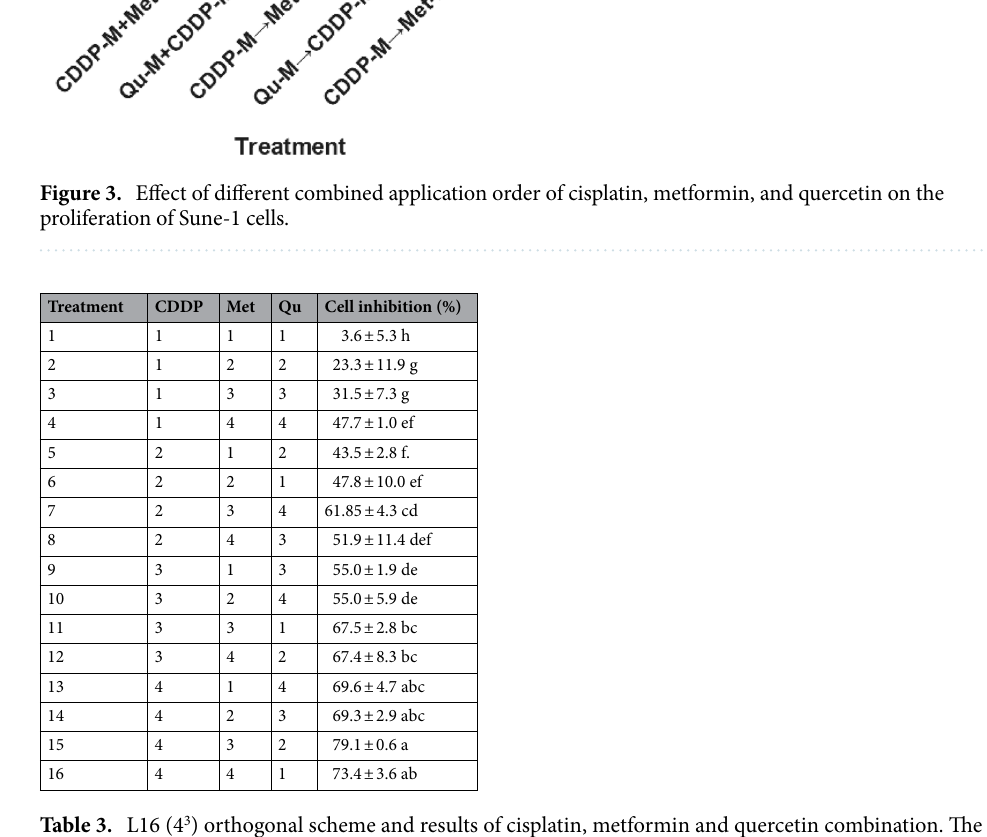
Table 3. L16 (4 3 ) orthogonal scheme and results of cisplatin, metformin and quercetin combination. The 4 levels of each drug are as follows: CDDP 1 = 0.0, CDDP 2 = 3.3, CDDP 3 = 7.6 and CDDP 4 = 8.6 (μg/mL). Met 1 = 0.0, Met 2 = 3.4, Met 3 = 7.7 and Met 4 = 8.7 (mmol/L). Qu 1 = 0.0, Qu 2 = 53, Qu 3 = 63 and Qu 4 = 73